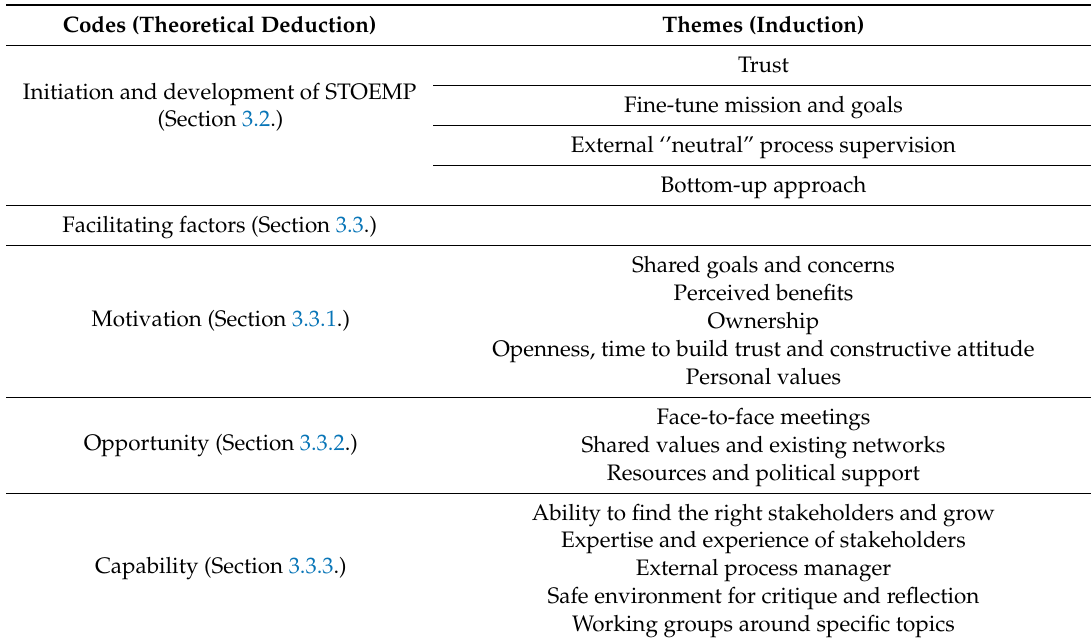
Table 1. Code book with theoretically deduced codes and inductively created